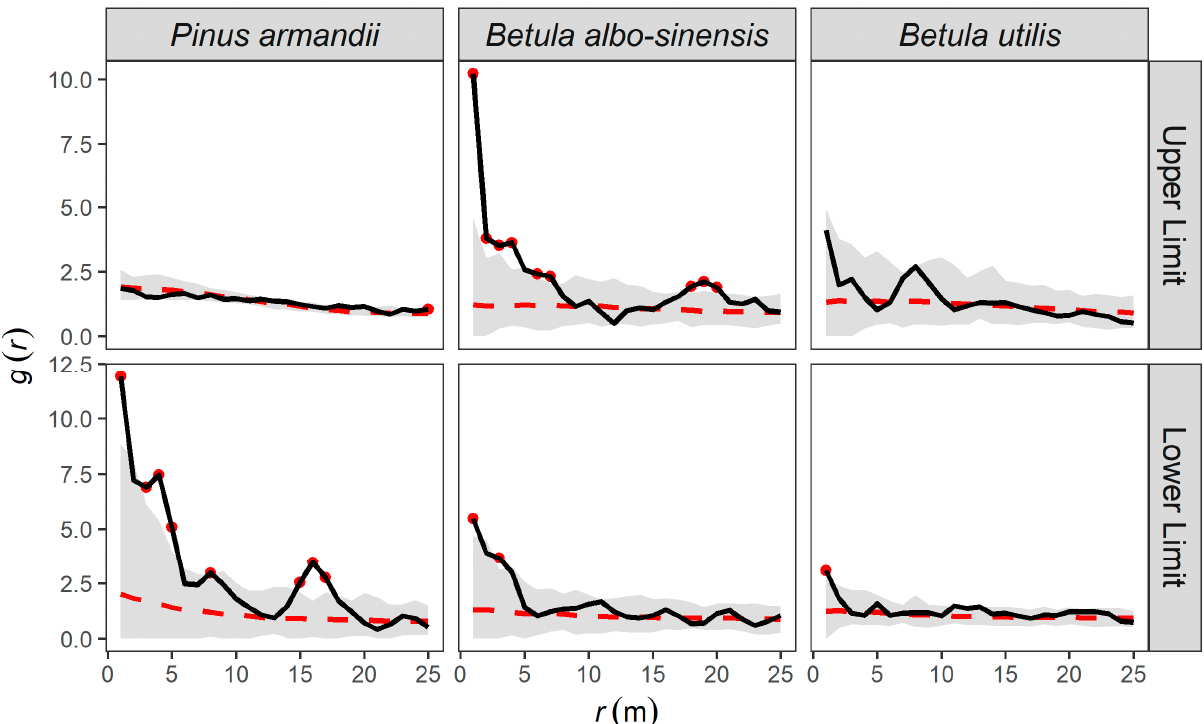
Figure 7. HP null model analysis of spatial patterns of P . armandii , B . albo-sinensis , and B . utilis at the upper limit and the lower limit of the treeline patch. Note: the red points are the g -values beyond the upper envelope at a corresponding scale, the blue points are the g -values under the lower envelope at a corresponding scale.